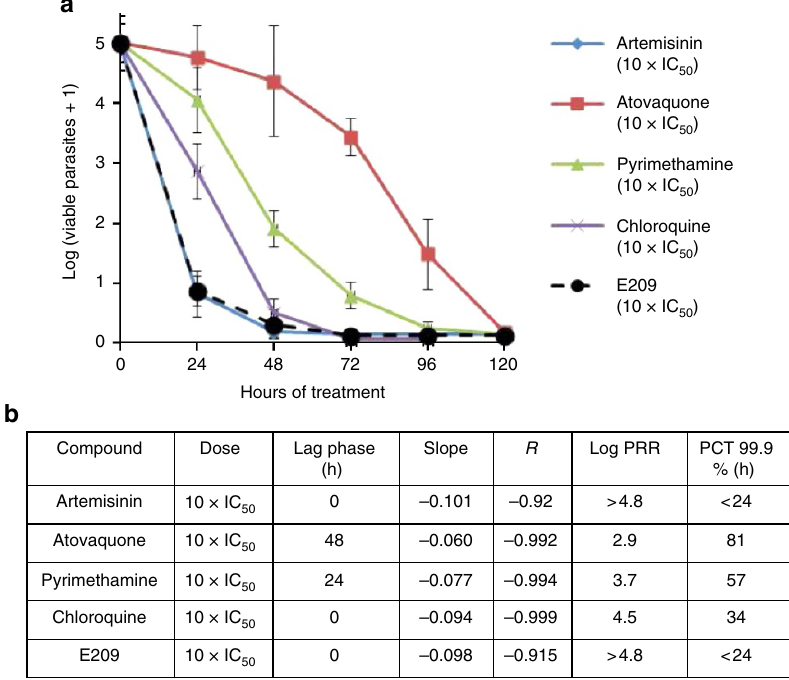
Figure 2 | Parasite reduction ratios of clinically used anti-malarials and E209. ( a ) In vitro PRR—number of viable parasites after E209 treatment (10 (cid:2) IC 50 ) is compared with the profile shown by standard anti-malarials ( b ) Lag phase, log 10 PRR and parasite clearance time (PCT) values for E209 and a selection of standard anti-malarials. The in vitro parasite reduction rate assay was used to determine onset of action and rate of killing as previously described 20 . P. falciparum was exposed to E209 at a concentration corresponding to 10 (cid:2) EC 50 . The number of viable parasites at each time point was determined as described by Sanz et al. 20 Four independent serial dilutions were done with each sample to correct for experimental variation; error bars, s.d. Previous results reported on standard anti-malarials tested at 10 (cid:2) EC 50 using the same conditions are shown for